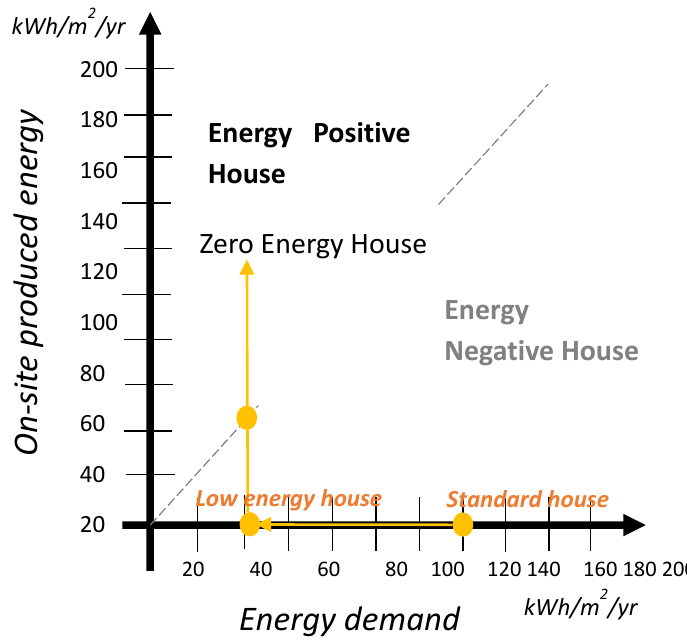
Figure 1. Concept for achieving net zero-energy and energy-positive (plus-energy) buildings [16]. A whole-house system approach integrates across passive design, e ffi cient heating and ventilation, and the use of renewables [17,18]. The use of heat pumps is generally applicable for energy-positive housing, where a lower-temperature heating system is more appropriate [19]. Research has identified the importance of the balance between renewable energy and heat pump performance and opportunities energy-positive performance for groups of houses using heat pump technology